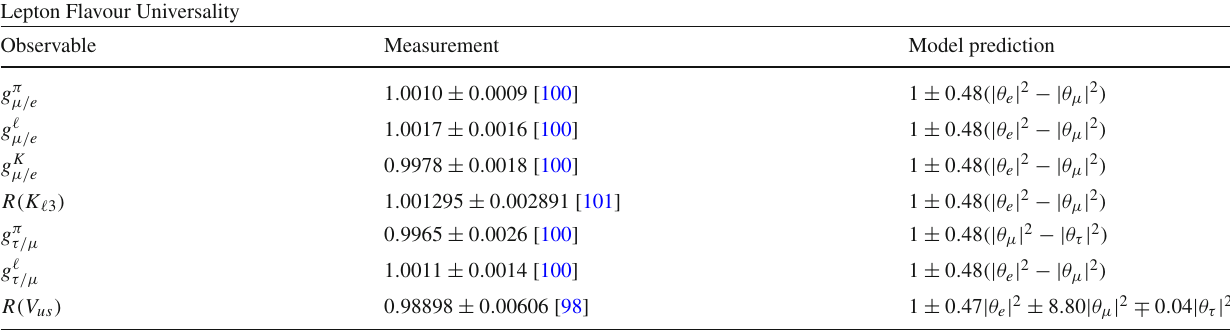
Table 6 Current constraints on and model predictions for the LFU ratios taken into account in this work. For R ( V us ) , the given experi- mental value refers to the case of N f = 2 + 1 + 1 dynamical quark flavours in the lattice simulations from which the relevant decay con- stants are extracted. The case of N f = 2 + 1 quark flavours gives rise